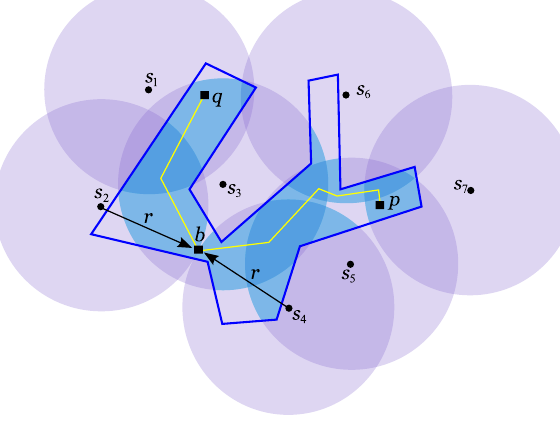
Figure 13. The yellow 2 -path between p and q on R only exists if the antennas’ transmission ( P ( p, q )) = r . The 2 -covered regions of R are shown in light range is at least MR S,R